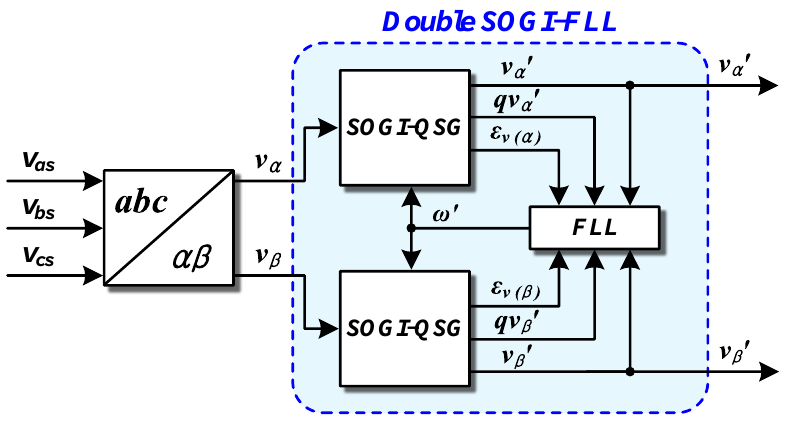
Figure 12. 3-phase SOGI-FLL (= DSOGI-FLL).